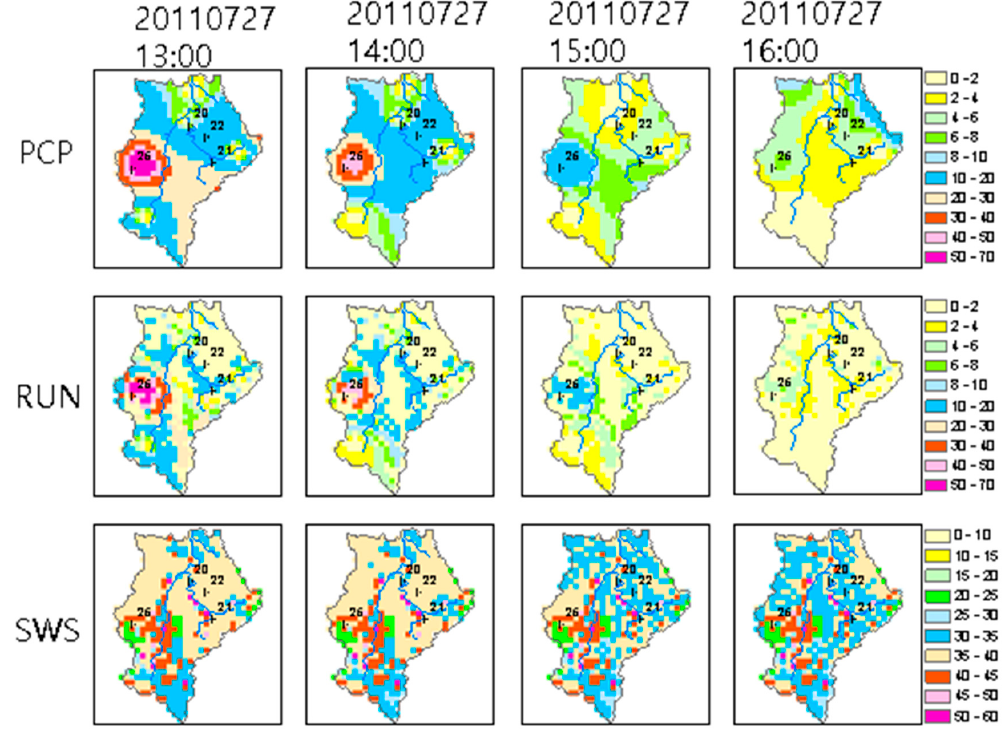
Figure 7. Spatial distribution map of rainfall (PCP), overland flow (RUN), and root zone soil water (SWS) at 1 km resolution in sub-basin No. 31 (see Figure 4a) for flash flood event (13:00–6:00 27 July 2011). Table 3. Basin mean for rainfall (PCP), overland flow (RUN), and soil water in root zone (SWS) in sub-basin No. 31 for the flood event on 21 July 2011.